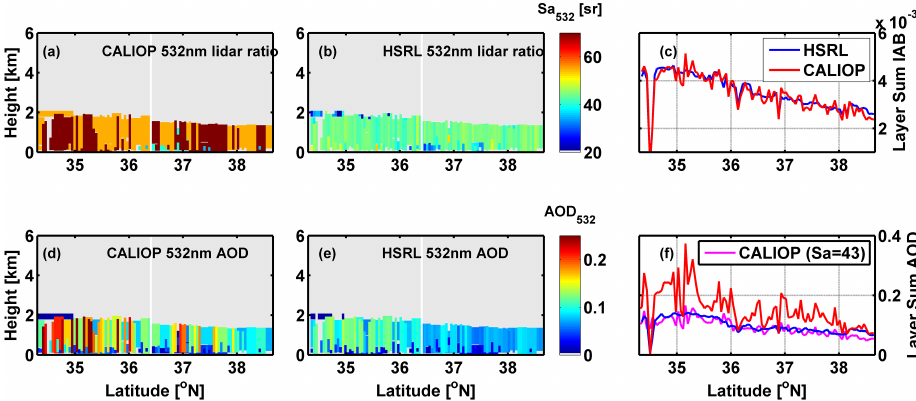
Figure 4. The CALIOP layer lidar ratio time series (a) and corresponding HSRL layer lidar ratio time series (b) from 7 February 2009. The corresponding CALIOP and HSRL layer AOD time series ( d and e , respectively), the layer-summed IAB from CALIOP and HSRL (c) , and the column (layer summed) AOD from CALIOP and HSRL (f) . In (f) , the magenta line represents the CALIOP level 2 column AOD analyzed with a lidar ratio of 43sr (see